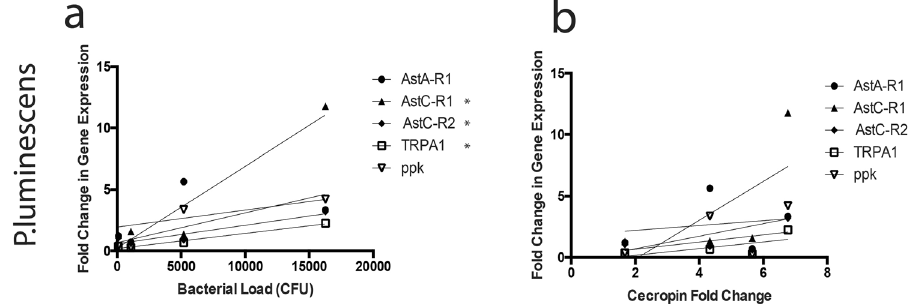
Figure 2. Allatostatin-C receptors and TRPA1 expression in Drosophila significantly correlates with bacterial load during P . luminescens infection. Correlation and linear regression lines for nociceptive gene expression in w 1118 flies over time plotted against ( a ) bacterial load and ( b ) Cecropin A1 expression following P . luminescens infection. Bacterial load significantly correlates with TRPA1 , AstC-R1 , and AstC-R2 expression upon infection with P . luminescens via two-tailed linear regression analysis (n = 3–4 groups of 10 flies per time point, * p <